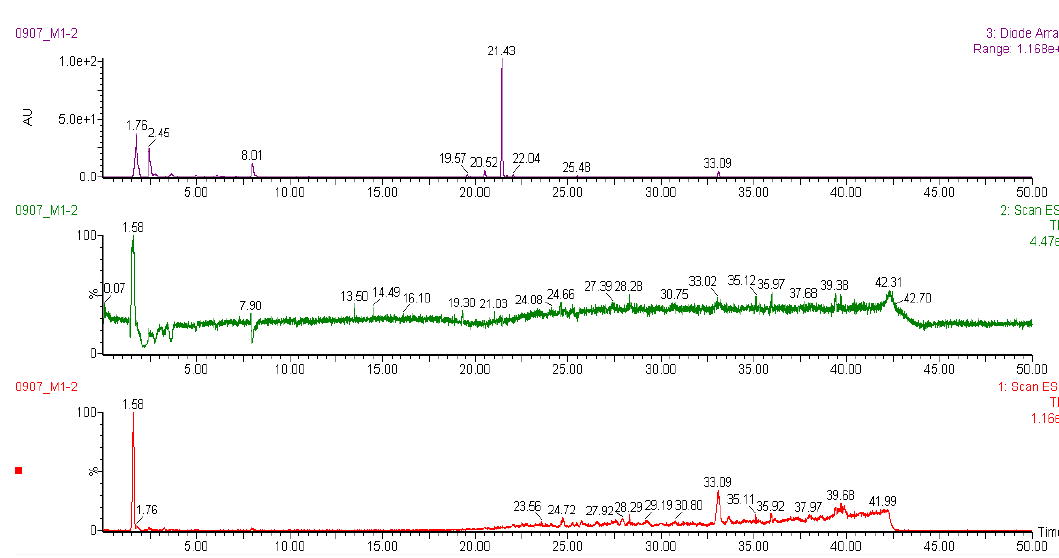
Figure 10. The LC-MS chromatogram of the methanol extract of Racomitrium moss. Table 1. Identification of chemical constituents from methanol extracts of liverwort and Racomitrium moss by LC-MS. Peak